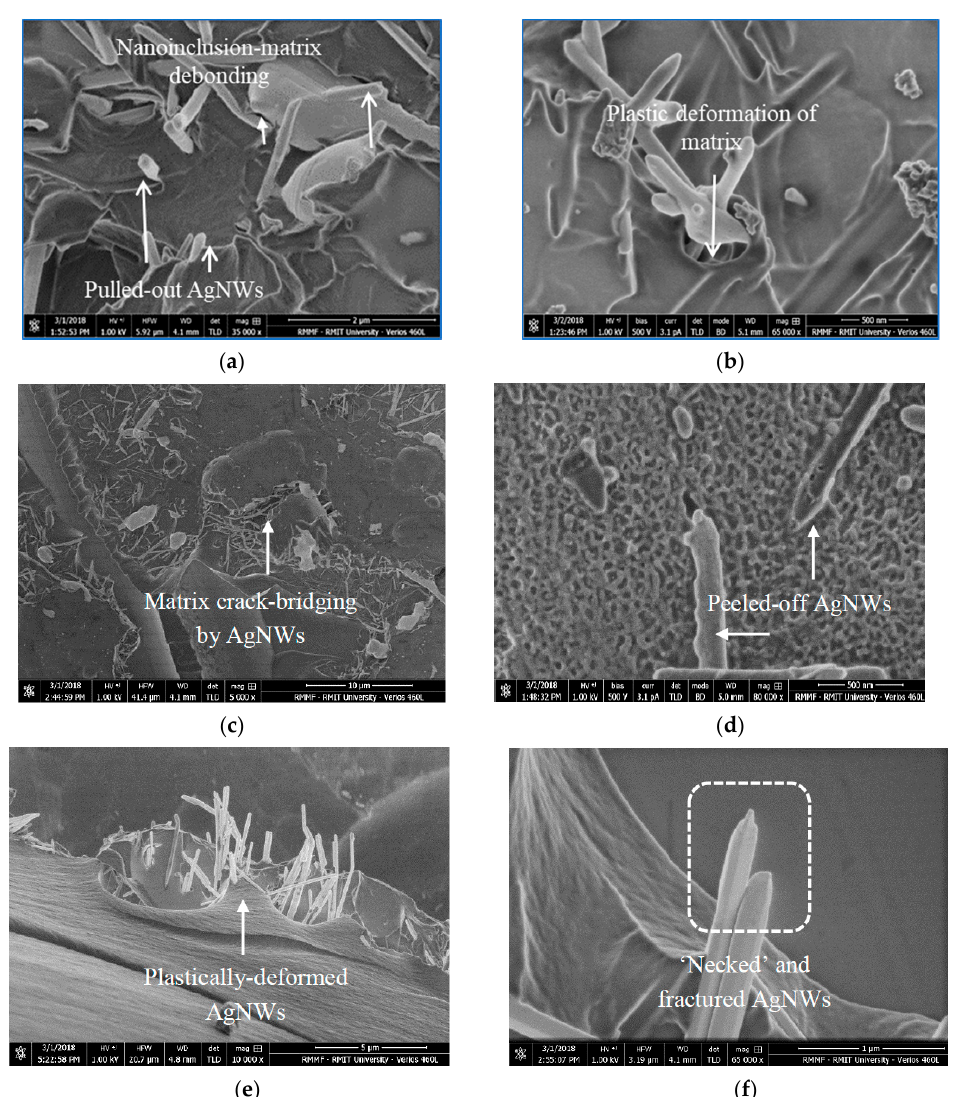
Figure 7. SEM images showing ( a ) debonded and pulled-out AgNWs, ( b ) plastically deformed epoxy matrix, ( c ) matrix crack-bridging by AgNWs, ( d ) aluminium-surface imprints left behind after AgNWs peeled off, ( e ) plastically deformed (i.e., straightened) AgNWs and ( f ) fractured AgNWs revealing localized plastic deformation (i.e., ‘necking’).